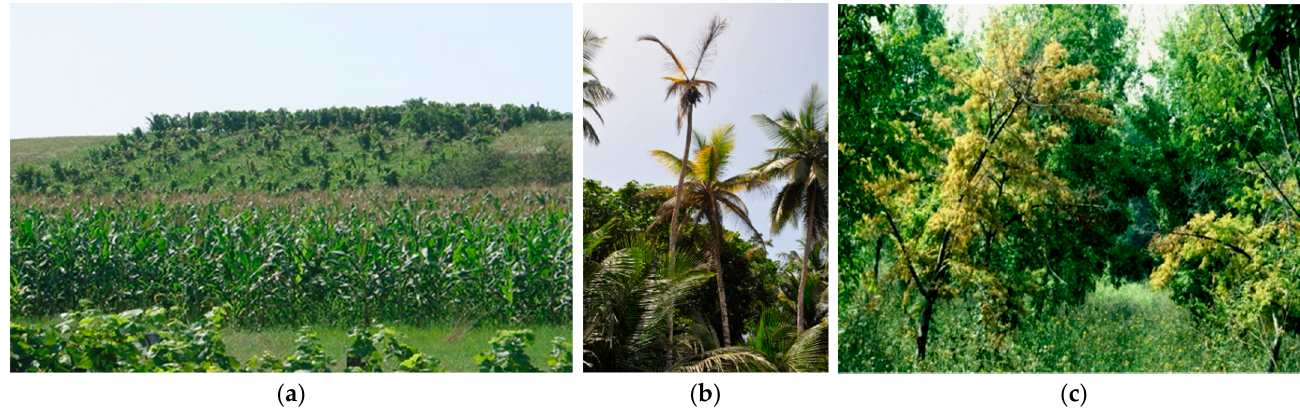
Figure 7. Grapevine yellows ( a ), coconut lethal yellowing ( b ), and elm yellows ( c ) associated with the presence of diverse phytoplasmas. Table 4. Molecular diversity and geographic distribution of selected phytoplasmas belonging to different ribosomal groups/‘ Candidatus Phytoplasma’ species (marked by different color) associated with yellows and decline symptoms.